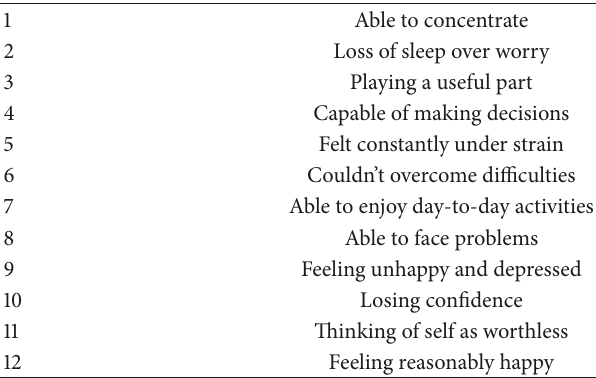
Table 1: Items of